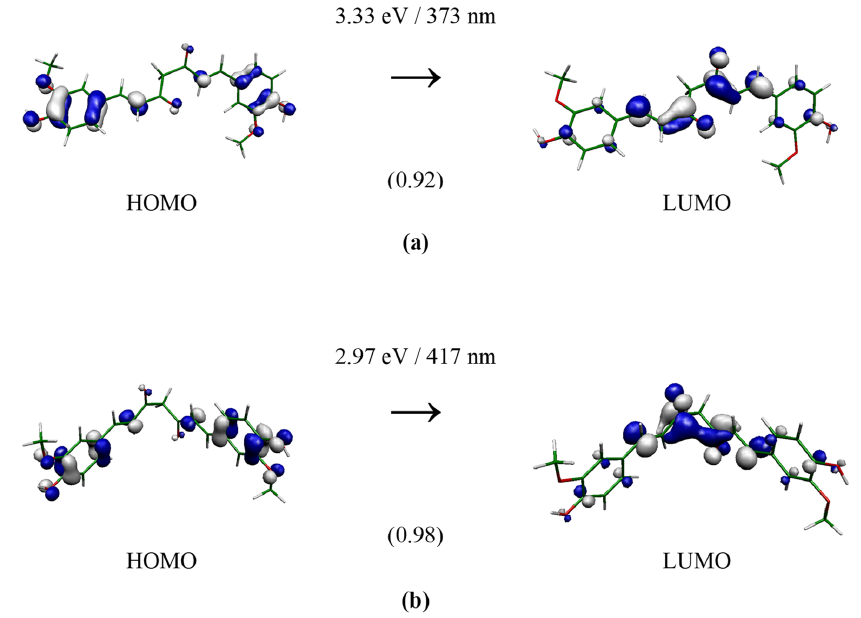
Figure 3. TD-B3LYP(SMD = water)/aug-cc-pVDZ//M062X/cc-pVDZ electron transition forming 2 1 B state of curcumin keto-form Ia ( a ) and Ib ( b ) of C 2 group. The depicted orbital isosurface is 0.05 a.u. The oscillator strengths (in atomic units) are in parentheses.